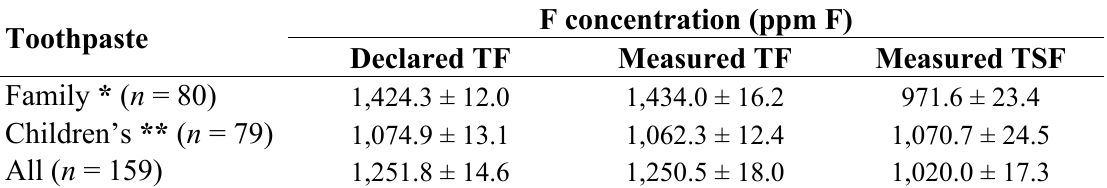
Table 1. Concentration (ppm F) of total fluoride (TF) declared on label, TF found in lab analysis and total soluble fluoride (TSF) measured in toothpastes according to type of toothpaste (mean ± standard deviation; n